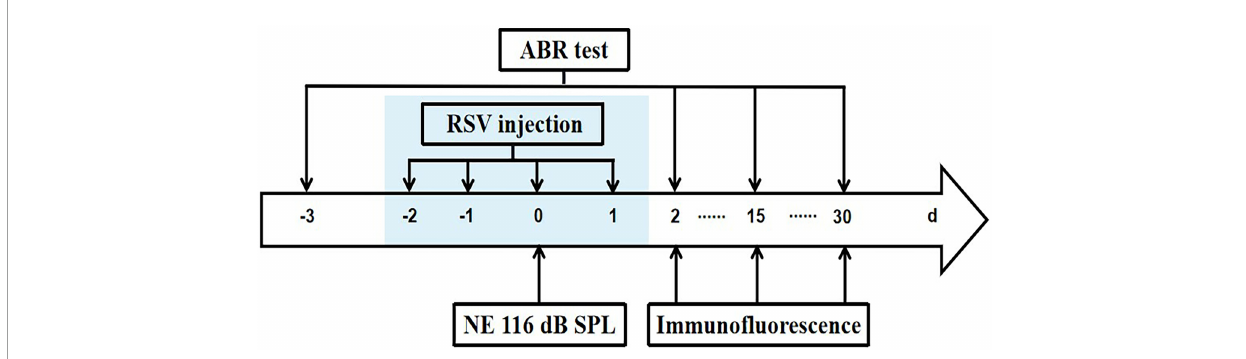
FIGURE1 Experimental timeline. Mice were exposed to 8 k 116 dB SPL noise on day 0. Resveratrol (RSV) was injected on –2, –1, 0, and 1 days. Initial ABR tests were performed on 3 days before NE and repeated ABR tests were done 2, 15, and 30 days after NE. After ABR recordings, immunostaining was carried out on 2, 15, and 30 days after